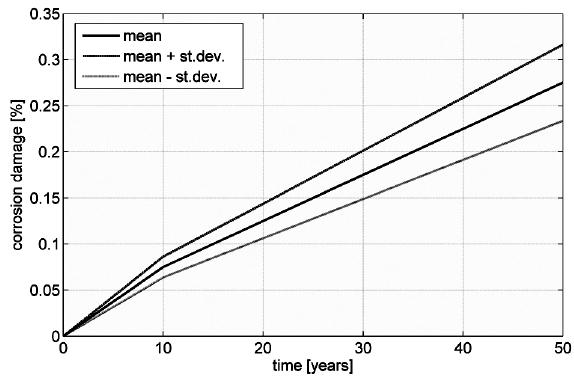
Fig. 7. The dimensionless corrosion damage ξ ( t ) as a function of time t